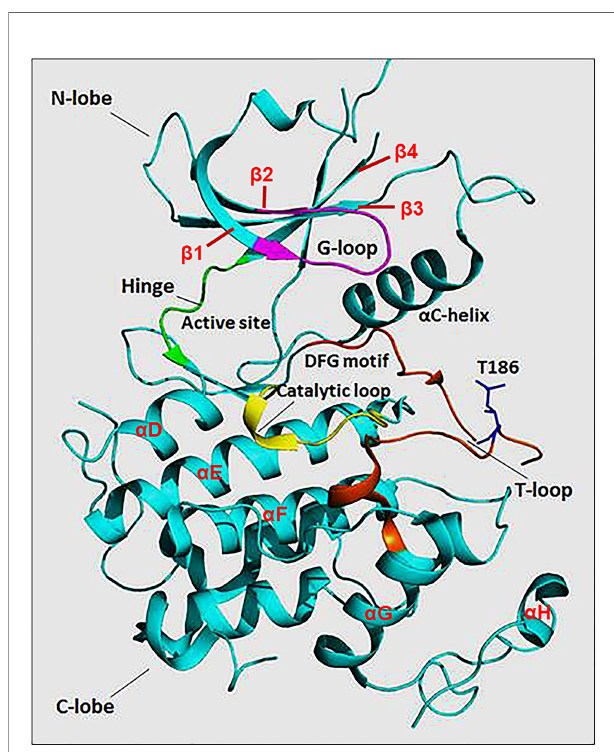
FIGURE 2 | The protein structure of monomeric CDK9 (Protein Data Bank: 3BLQ). The bilobal CDK9 structure is dominated by N-terminal b -sheets (1-4 are shown) and C-terminal a -helices (D-H are shown). The C-terminal also contains b -sheets (6-9, not shown). The two lobes are connected by a hinge region (green) that binds the adenine moiety of adenosine triphosphate (ATP). The N-terminus contains an a C helix and glycine-rich loop (G-loop, purple) which binds cyclin and ATP, respectively. The C-terminus comprises the catalytic loop (yellow), T-loop (brown), and DFG motif that binds Mg +2 . The threonine residue (Thr186) involved in CDK9 activation is found in the T-loop